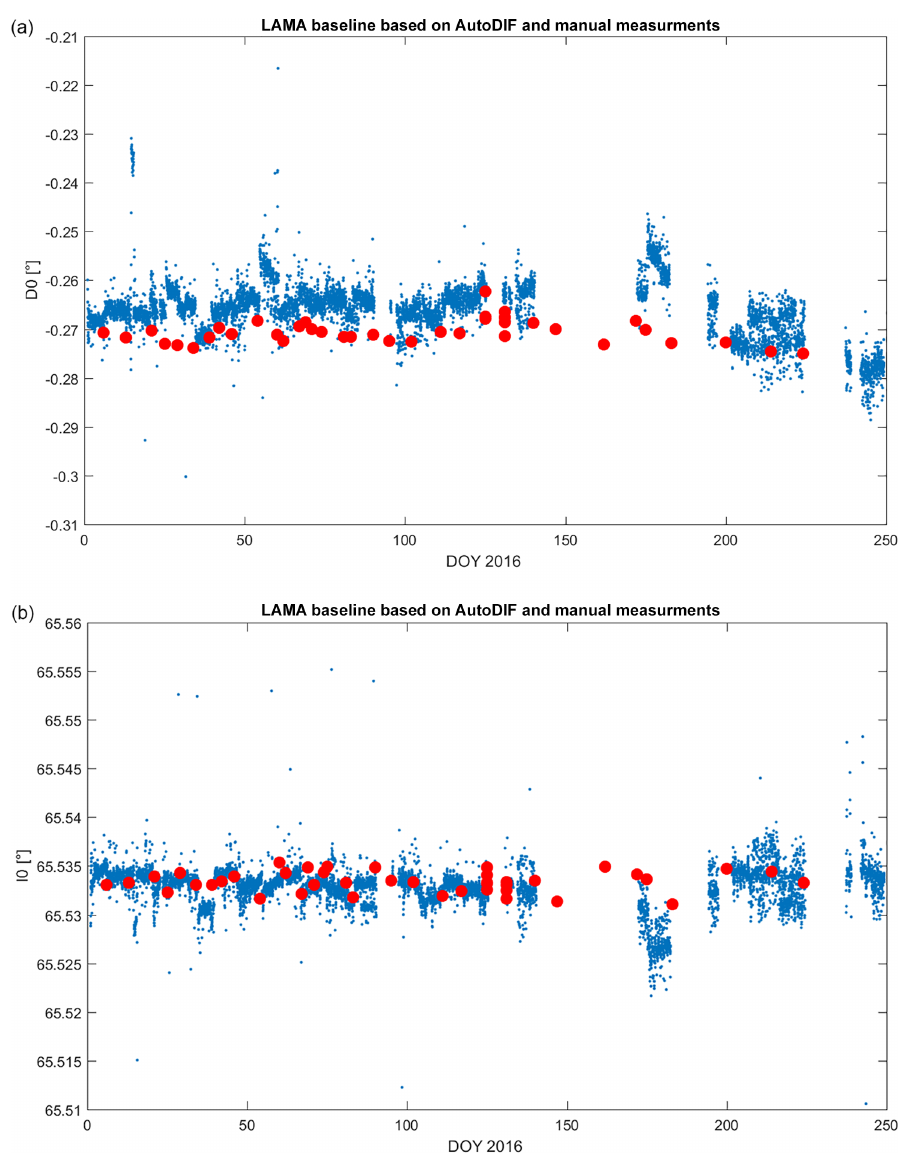
Figure 5. LAMADOU intercomparison baselines for 2016 of AutoDIF measurements (blue dot) and manual measurements with Zeiss